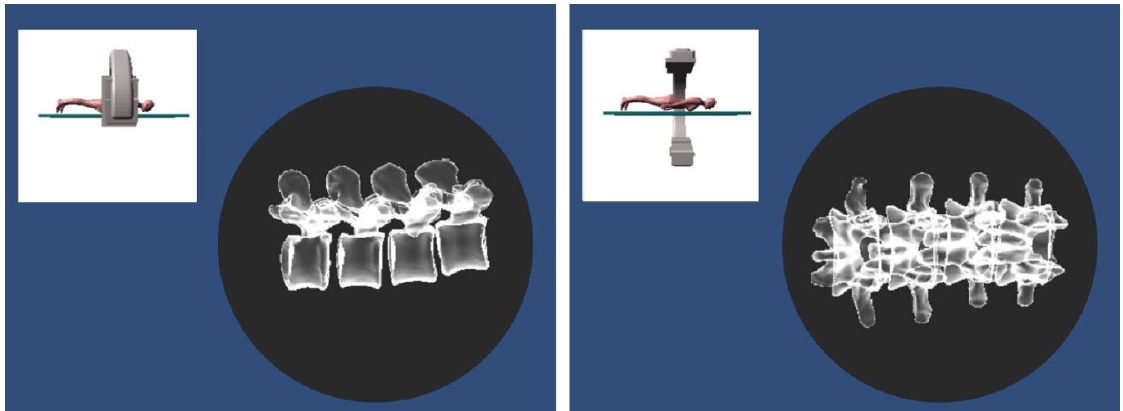
Figure 6. Two screenshots of the User Interface during the simulation in Virtual X-ray Visualization modality. The User Interface shows the relative positioning of the Virtual C-Arm and the patient and the corresponding simulated fluoroscopic image.